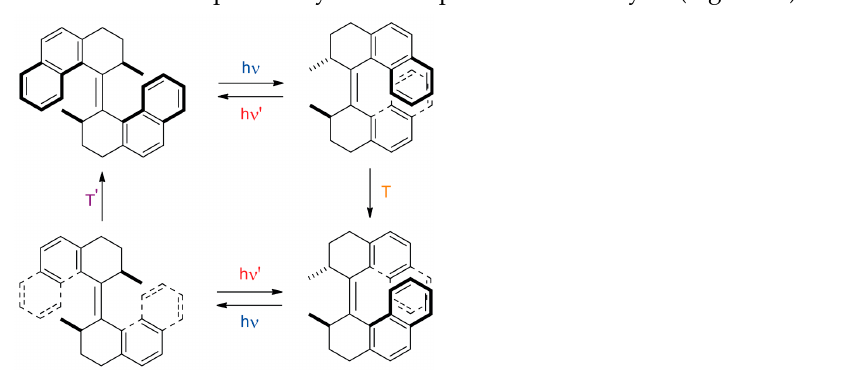
Figure 12. Four-step isomerization cycle of the photoresponsive overcrowded alkene-based molec- ular motor 12 prepared by Professor Feringa’s research group [83].